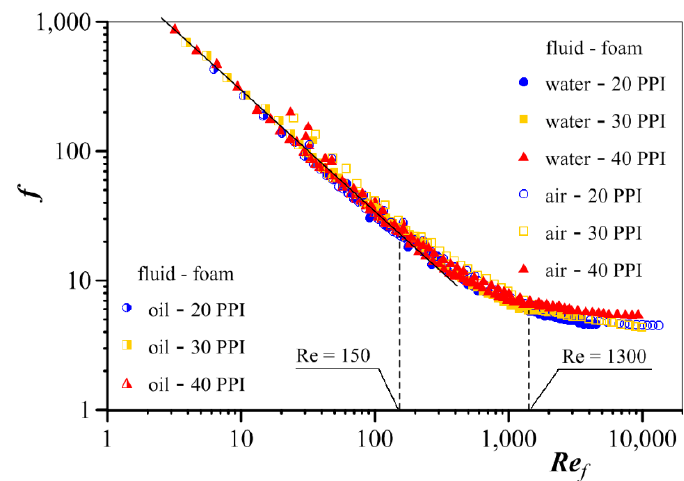
Figure 13. Friction factor for all single-phase flow cases tested.